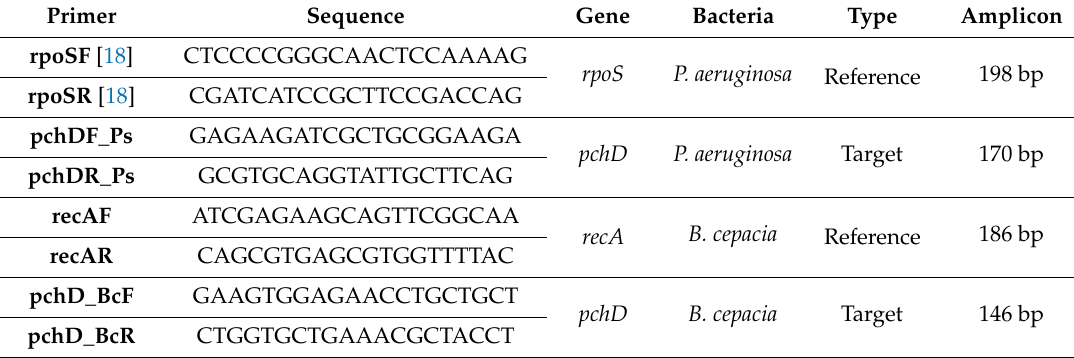
Table 3. Primers’ list.